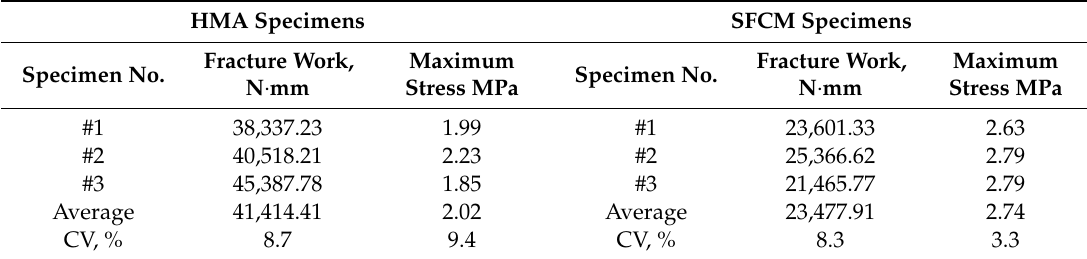
Figure 5. Stress-strain relationship of fatigue testing. Table 2. Summary of fracture work and maximum stress (20 °C).